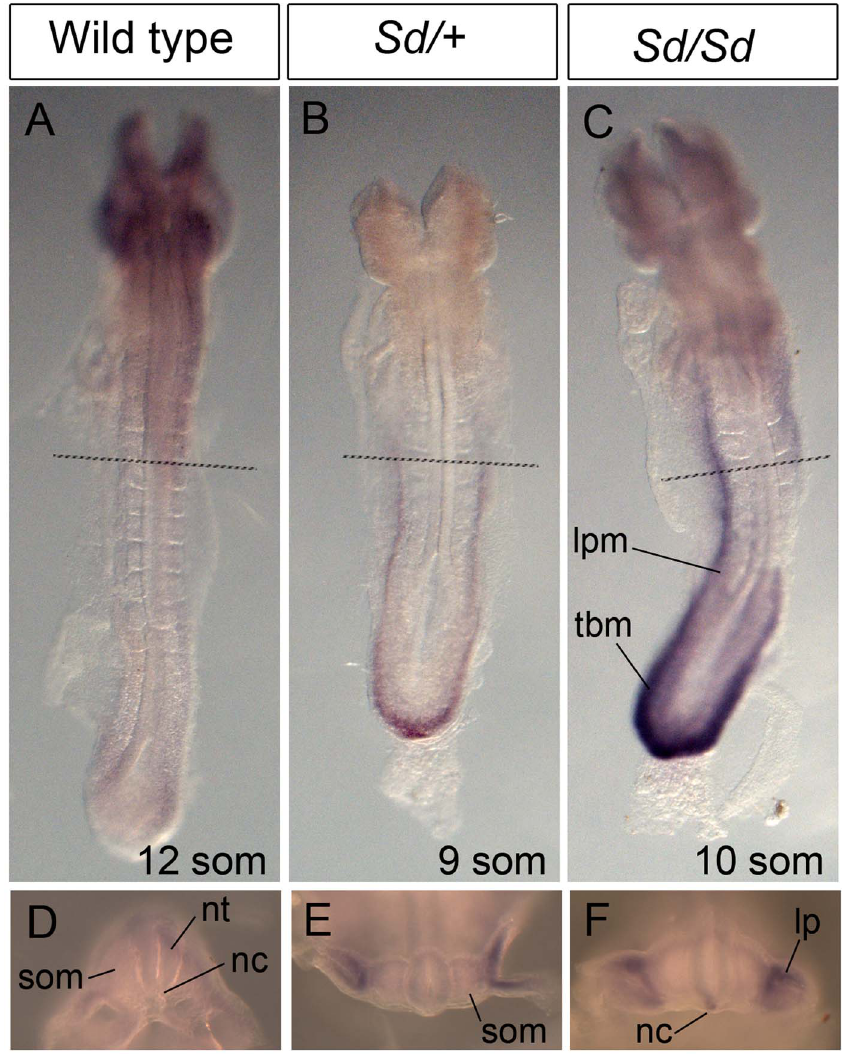
Figure 6. Ectopic expression of Ptf1a in Sd/ + and Sd/Sd embryos at E8.5. (A–C) Dorsal view of whole mount ISH showing Ptf1a expression in wild type, Sd/ + and Sd/Sd embryos at E8.5. Lines indicate corresponding slices in D–F. (D–F) Slices from embryos in A–C at the level of the fourth somite. Ptf1a is ectopically expressed in the lateral plate mesoderm (lpm) and tail bud mesenchyme (tbm) of Sd/ + and Sd/Sd embryos and in the notochord (nc) of Sd/Sd embryos. nt-neural tube, som-somite.